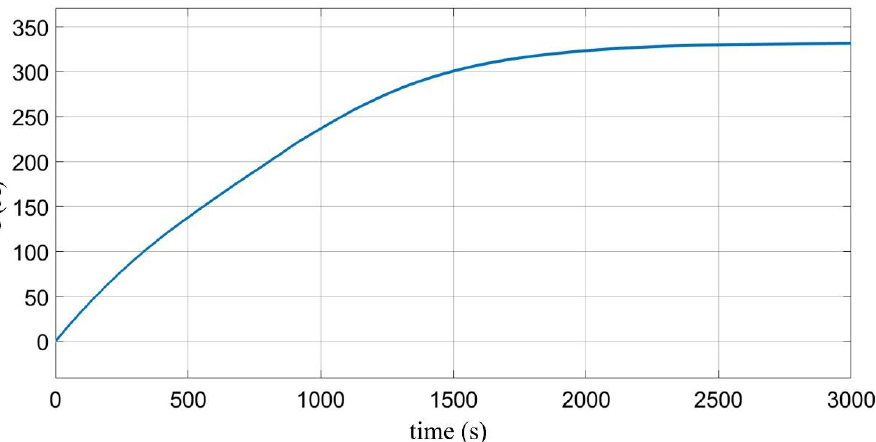
Figure 13. Transport current transient of the EcoSwing field winding powered by the transformer rectifier flux pump. The curve shown applies for both the cold and the warm layout.